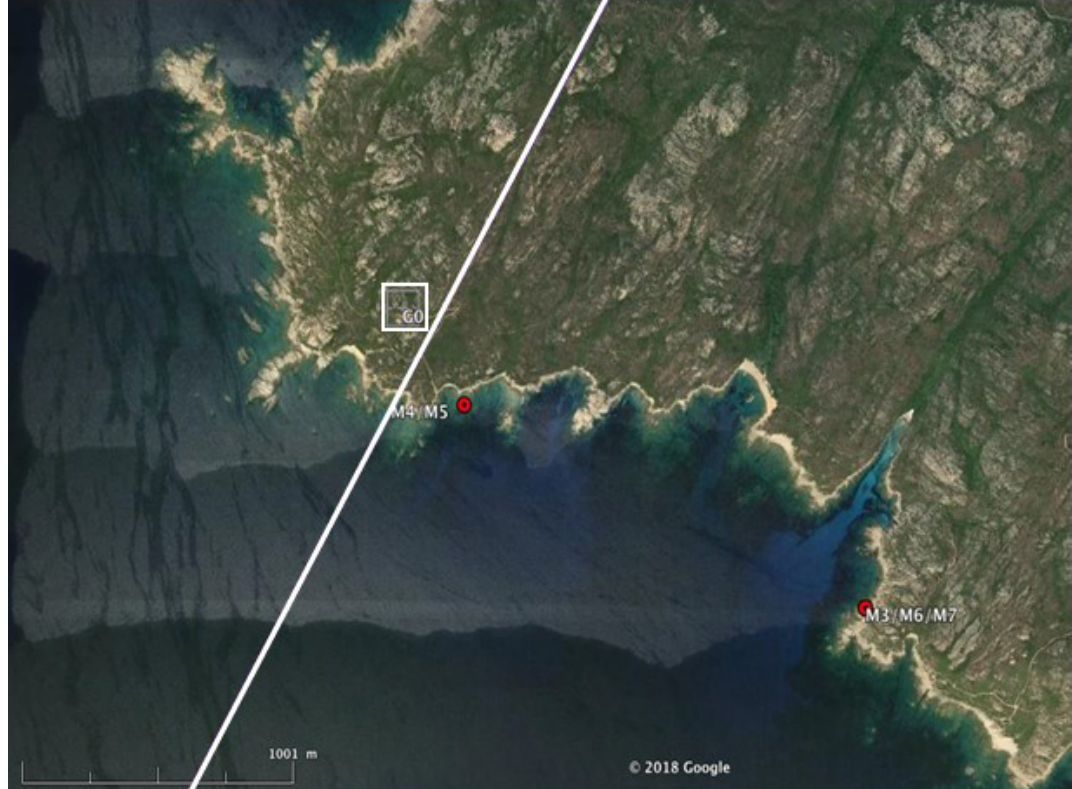
Figure 2. © Google Earth image of the Senetosa calibration site. The two tide gauge sites (referred as M4/M5 and M3) are shown by the red dots. The G0 reference marker (G0) is indicated by a white square and the Jason ground track by the straight white